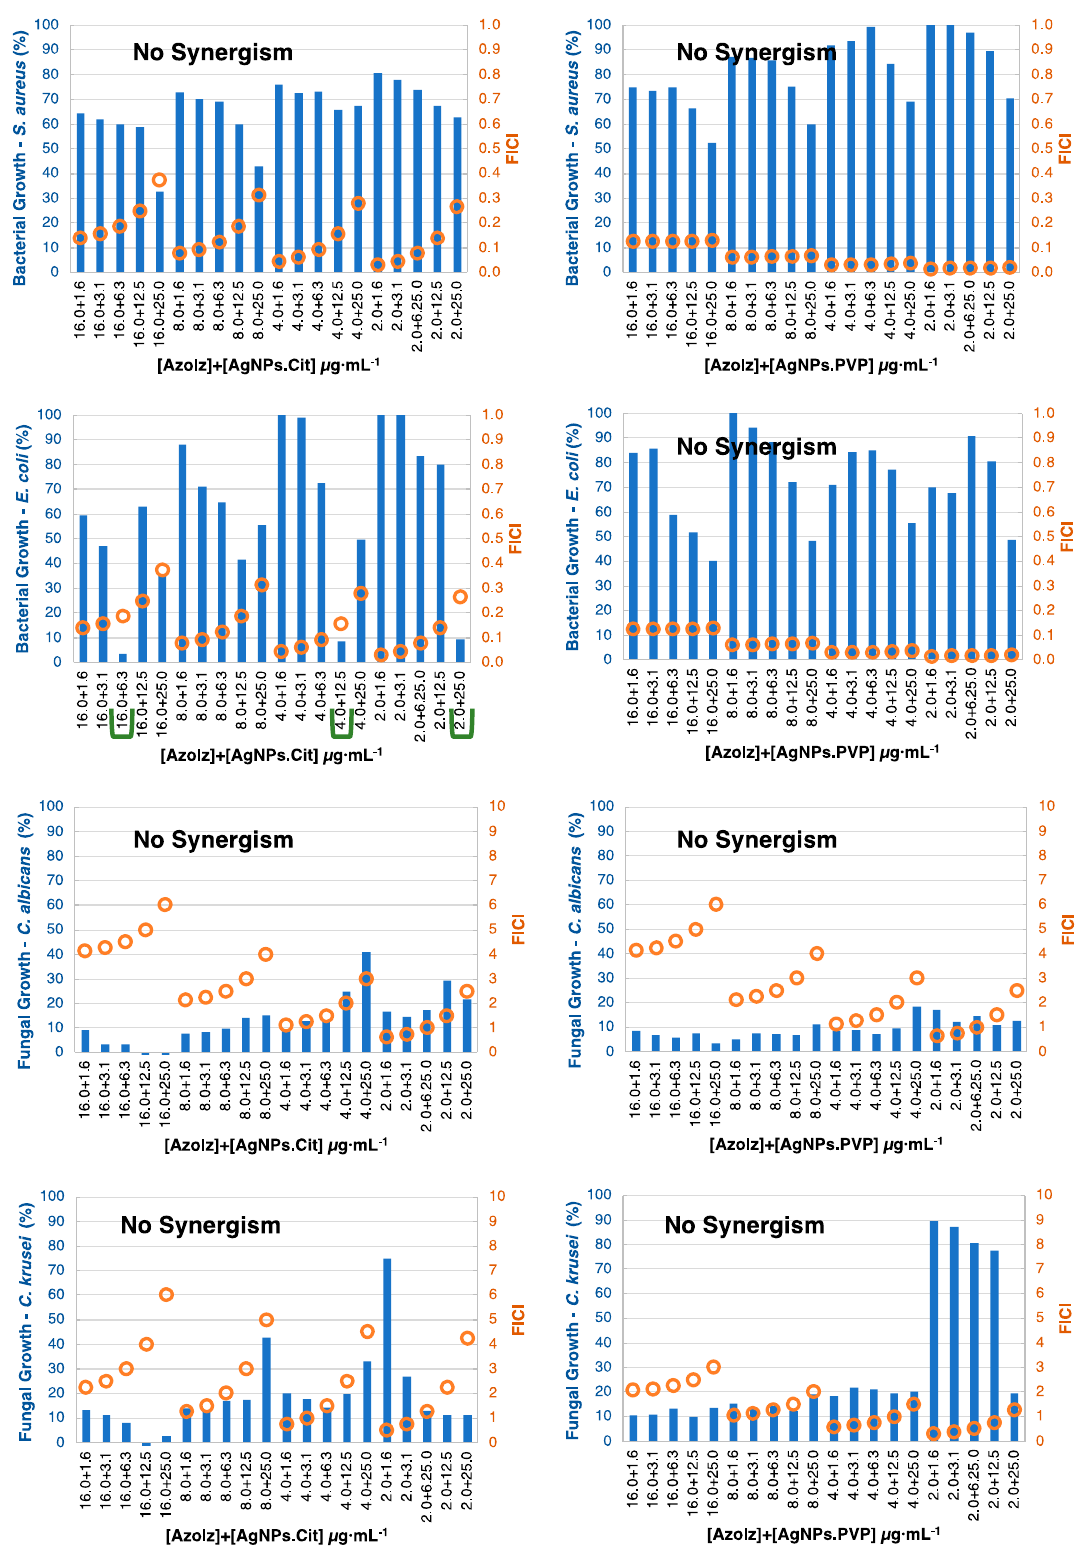
Figure 6. Checkerboard results by combining AzoIz (concentration ≤ 16.0 µ g · mL − 1 ) with AgNPs